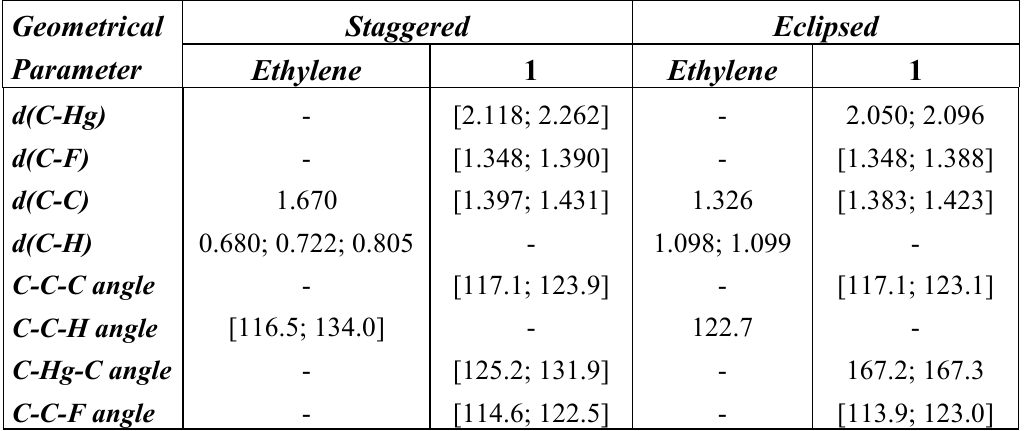
Table 3. Significant structural data for 1·ethylene · 1*